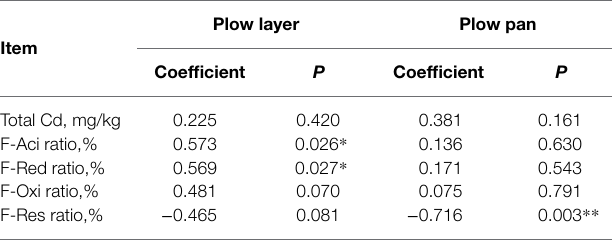
Asterisks indicate the significant correlation * p < 0.05; ** p <